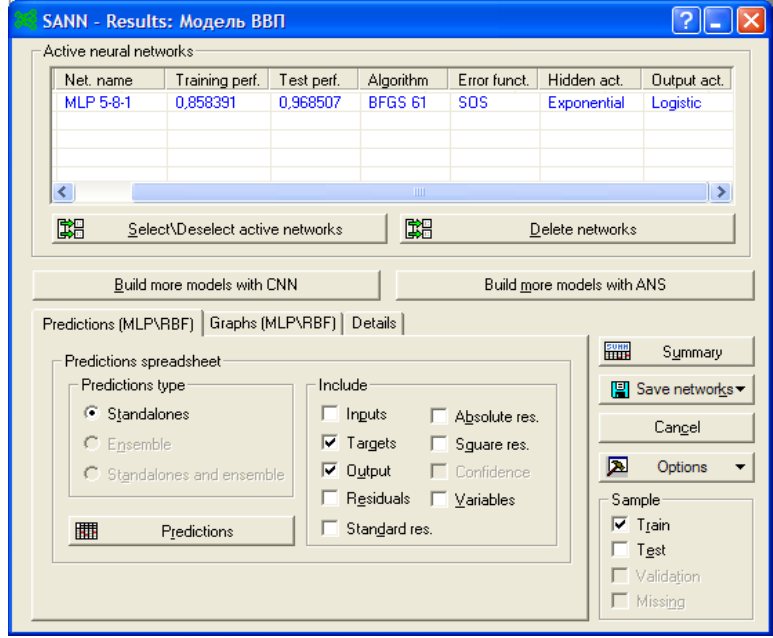
Fig. 3. The constructed neural network in STATISTICA